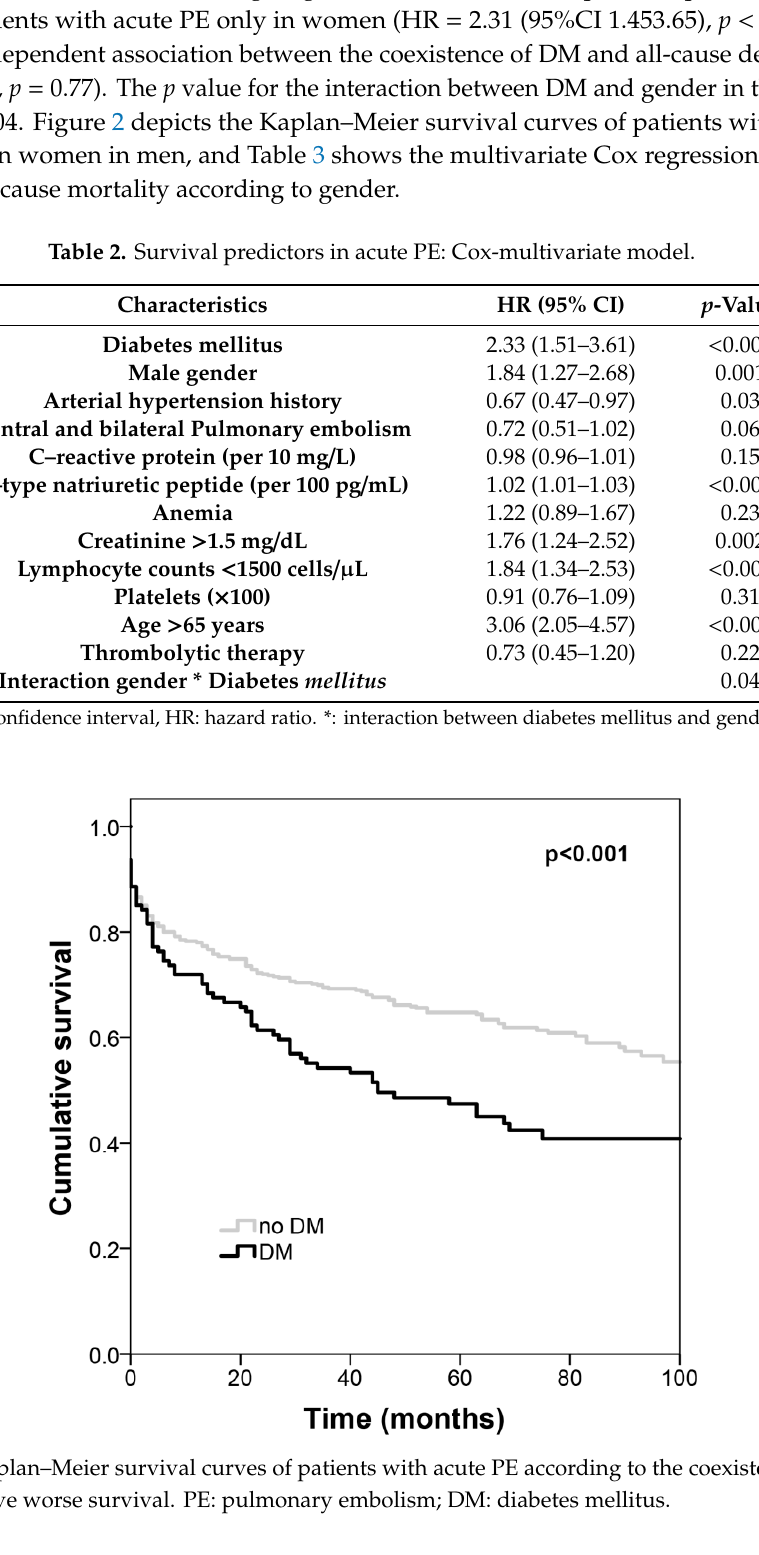
Figure 2. Kaplan–Meier survival curves according to the coexistence of DM separately in women ( left ) and men ( right ). Diabetes implies a survival disadvantage only in women. DM: diabetes mellitus. 4. Discussion In women hospitalized with acute PE, those with DM had a more than twofold higher risk of long-term all-cause death than their non-diabetic counterparts. DM did not influence prognosis in men with acute PE. Gender appears to interact with DM in the long-term outcome of acute PE. The differential impact of DM in men and women has already been described in various clinical contexts, namely in cardiovascular [1,6,7,15], renal [11] and neoplastic diseases [ 12,13,16]. Venous thromboembolism can be viewed as part of the cardiovascular disease continuum, as it shares risk factors, namely diabetes and atherosclerosis [13]. Several explanations have been proposed for this interaction between gender and DM in the prognosis of morbid conditions. Of all of the cardiovascular risk factors, the greatest weight of evidence of a female disadvantage is for diabetes. DM more than doubles the risk of CHD, but confers